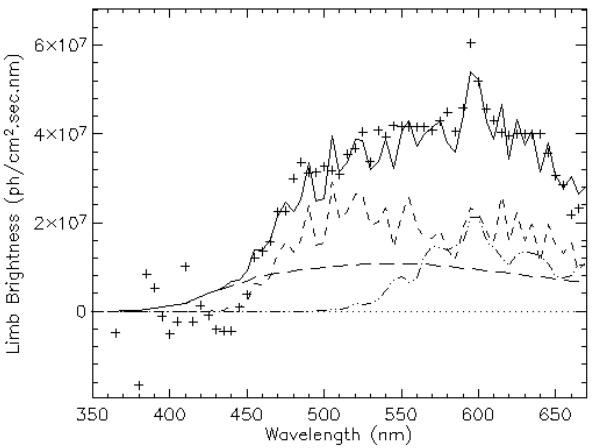
Fig. 4. Least-squares fit of the chemiluminescent FeO ∗ model spec- trum (dot-dot-dash), the NiO ∗ model spectrum (short dash), the chemiluminescent NO ∗ emission (long dash), and the total (solid) 2 to the GLO-1 observed airglow limb “continuum” from panel (C) of Fig. 2 (+ + +), all averaged over 5nm intervals. The large noise spikes in the difference spectrum at OI 558nm and OI 633 (panel (C) of Fig. 2) are replaced by straight lines. The ratio of NiO ∗ to FeO ∗ is 2.3 ± 0.2 and NO ∗ to FeO ∗ is 1.3 ± 0.2, integrated over the 2 full spectral range of Fig.